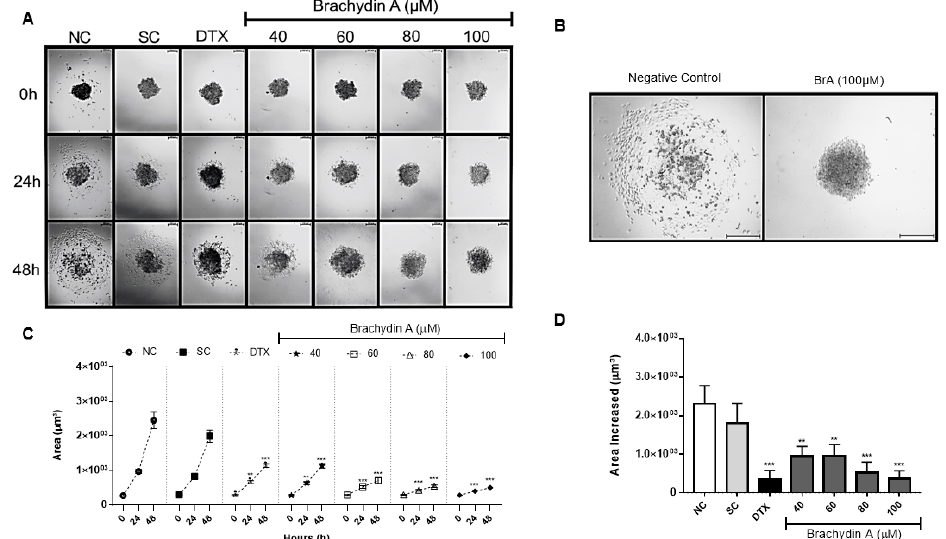
Figure 3. ( A , B ) Photomicrographs from DU145 spheroids in ECM gel obtained after 0, 24, and 48 h of exposure with Brachydin A (BrA) and respective controls. All images were acquired using the Axio Cam MRc capture system coupled to Axio LabA1 microscope, using the 10× objective, and analyzed using the AxioVision 3.1 software. Scale: 200 μ m. ( C , D ) Cell migration area ( μ m³) from DU-145 spheroids after 0, 24, and 48 h exposures with BrA and their respective controls. All points/bars represent the mean ± standard deviation of the covered area from six ( n = 6) spheroids/replicates in three biological experiments ( n = 3). * Values statistically different from the NC group at the time-point (date) (** p < 0.01; *** p < 0.001; ANOVA followed by Dunnett’s post-test). NC: negative control (RPMI 1640); SC: solvent control (1% DMSO); DTX: Docetaxel (50 µ M; positive control).